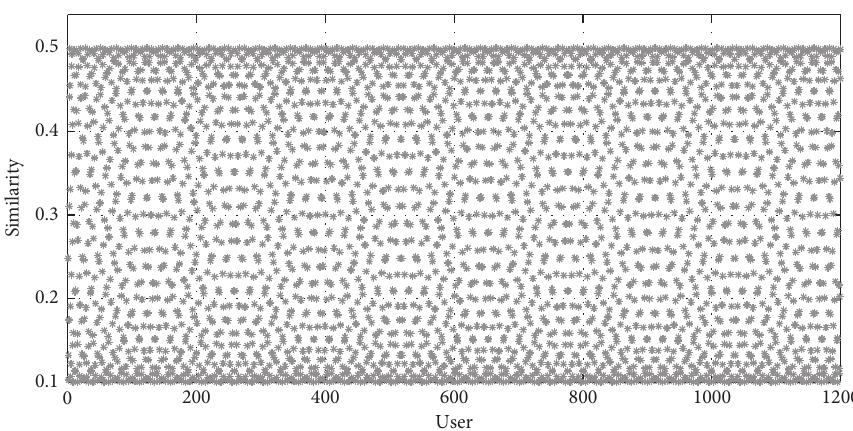
Figure 7: Distribution of similarity among users under the Jaccard similarity index.